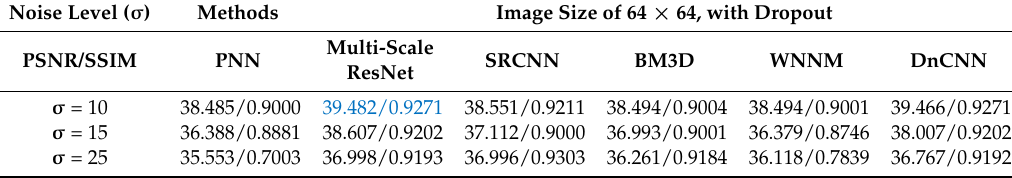
Table 5. The average results of our aerial-image model, where the multi-scale residual learning network (ResNet) was the proposed aerial-image denoising method in the paper. The corresponding experimental parameters were x = 5, y = 3, scaling parameter z = 4, and network depth of 26 (blue font indicates the best).